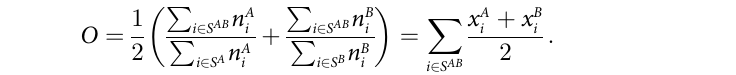
S1 Fig. Relationship between Spearman correlation and carrying capacity correlation ρ model data. Black points are averages of simulated data (point range corresponds to 2 stan- dard deviations). The black curve is obtained by a quadratic fit to the data, resulting in ρ